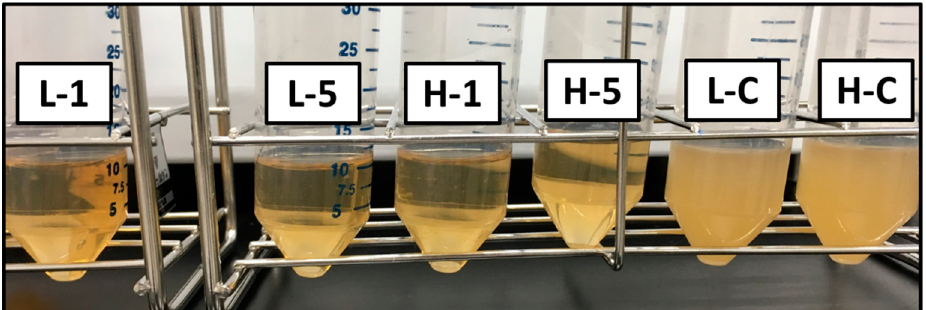
Figure 4. Naked-eye image of antibacterial test results by shaking culture method. L-1 and L-5 were 1 × 10 5 CFU/mL of Escherichia coli with GNT extraction liquids (GNTEL) 1 and 5, respectively. H-1 and H-5 were 1 × 10 7 CFU/mL of E. coli with GNTEL 1 and 5, respectively. L-C and H-C were 1 × 10 5 and 1 × 10 7 CFU/mL of E. coli with phosphate buffered saline (PBS), respectively. Table 1. Final concentration of E. coli after the shaking culture test. Label L-1 L-5 H-C Final concentration of E. coli (± S.D.)